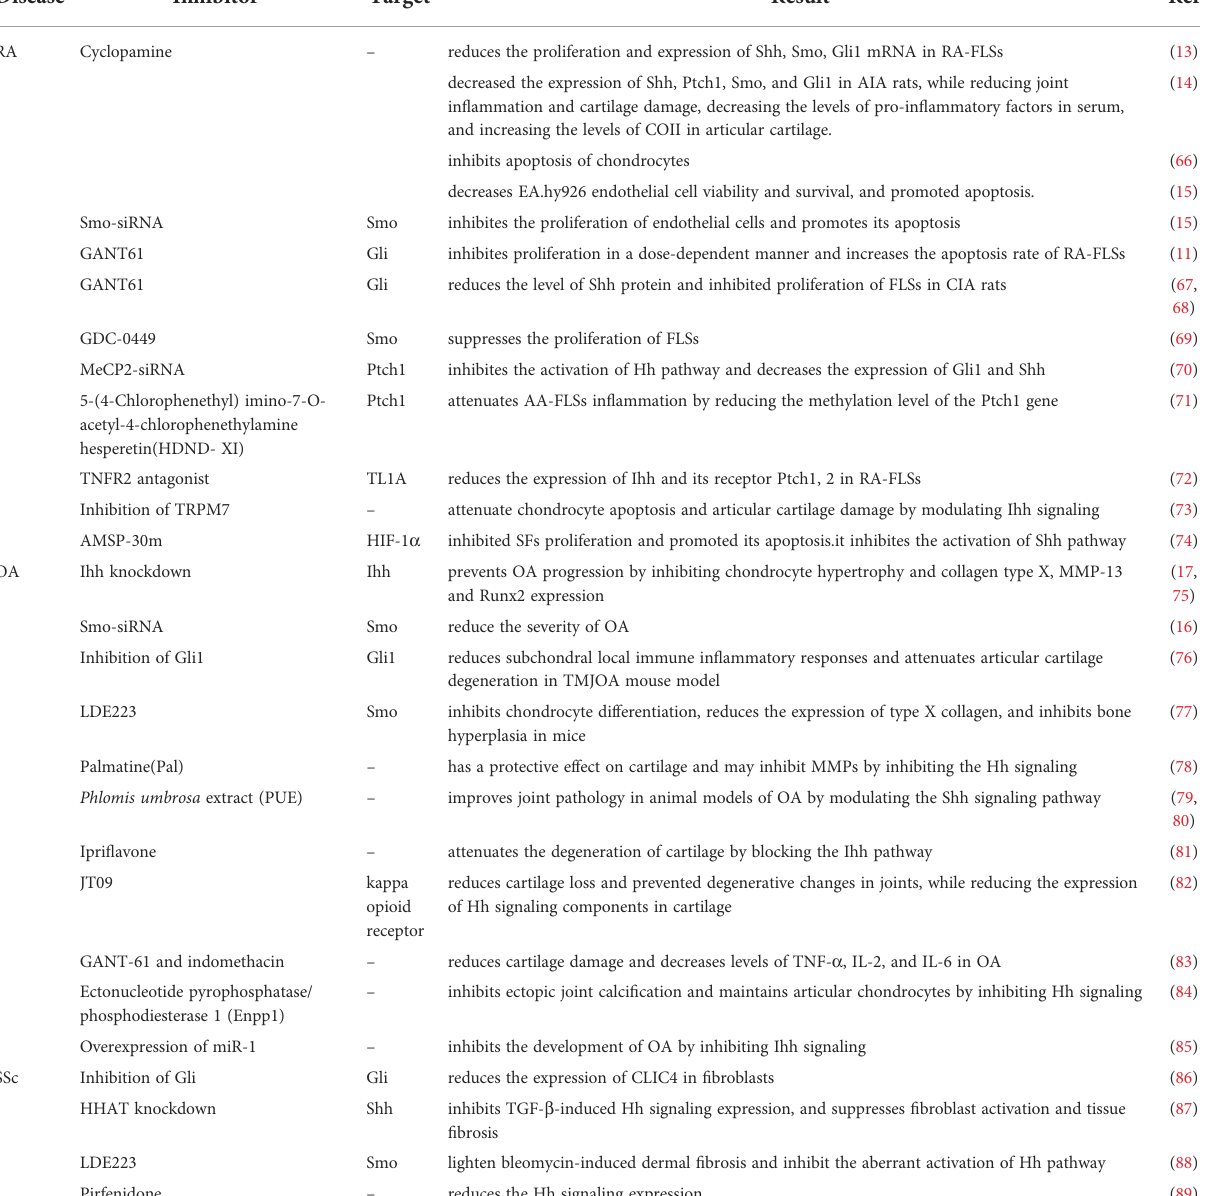
TABLE 2 Treatment of rheumatic diseases by targeting the Hh signaling pathway.